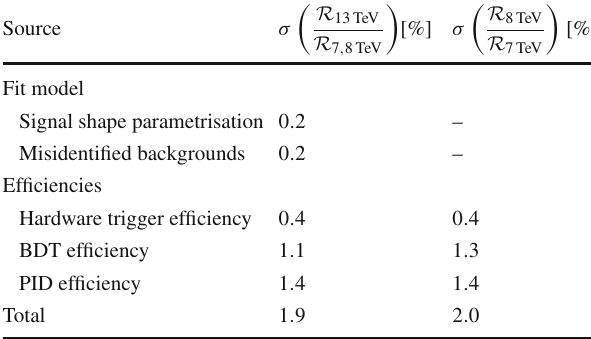
Table2 Relativesystematicuncertainty σ ontheratiooftheefficiency- corrected B 0 s → D + s π − and B 0 → D − π + yield ratios. The ratios / R / R R R 13TeV 7TeV and 13TeV 8TeV are reported together as the dif- ference of the systematic uncertainty for 7 and 8 TeV is negligible